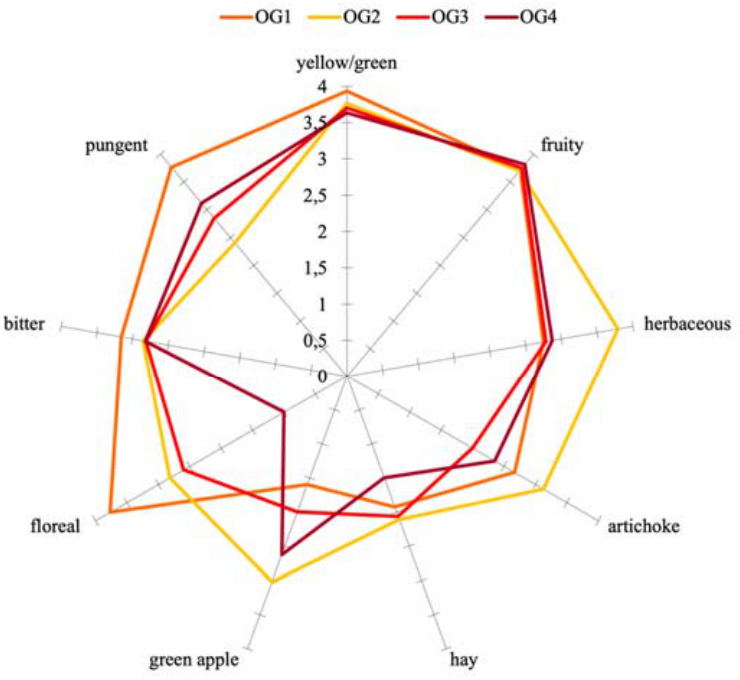
Figure 1. Sensory profile of Ogliarola olive oil obtained by adding three different concentrations of oxygen (0.2 L/min for OG2, 0.4 L/min for OG3, and 0.8 L/min for OG4) during crushing phase in comparison with control test (no oxygen added for OG1)